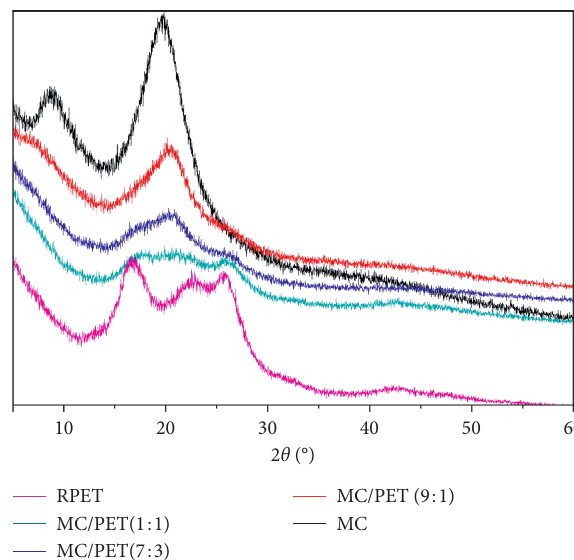
Figure 3: XRD patterns of original MC, RPET, and MC/PET films.